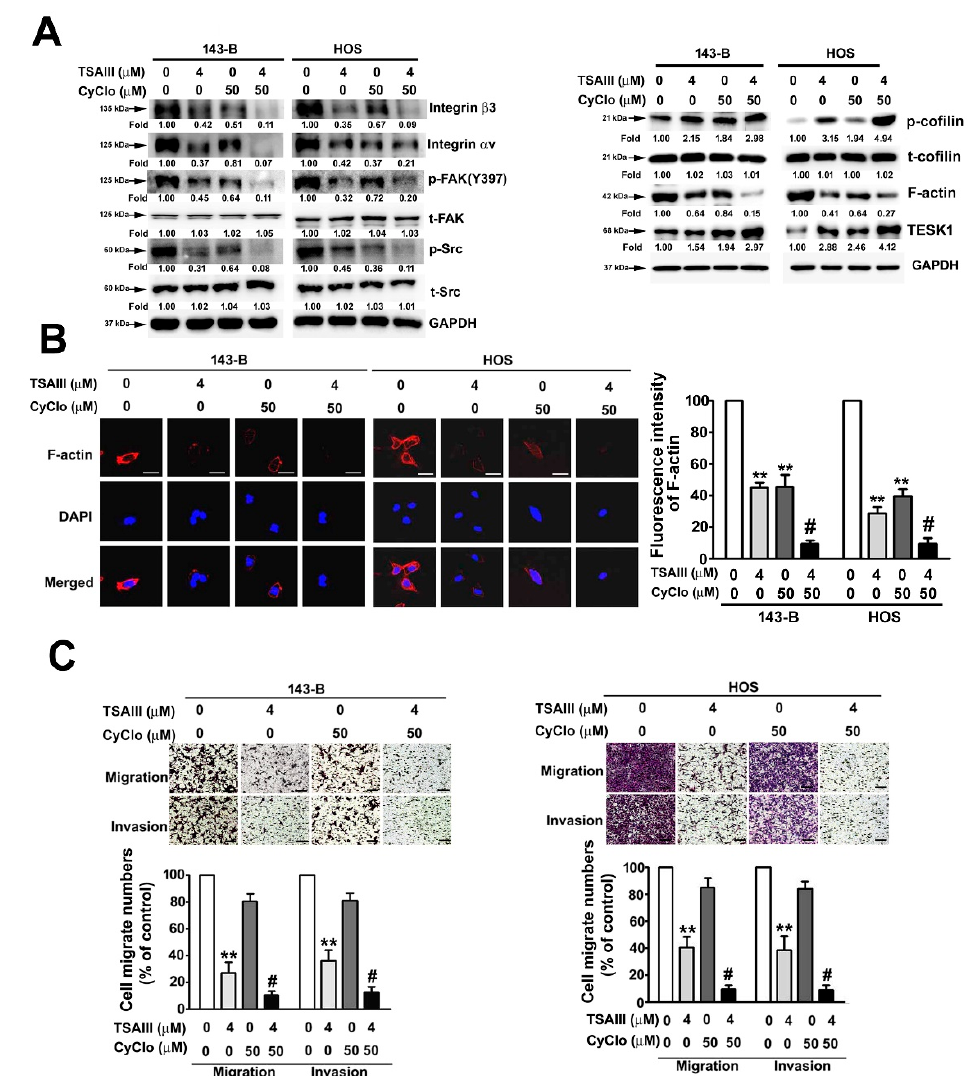
Figure 4. Synergistically inhibitory effect of TSAIII and Cyclo on migration and invasion of human osteosarcoma cells. ( A ) Human 143-B and HOS osteosarcoma cells were treated with various concentrations of TSAIII (0 and 4 µ M) and/or Cyclo (0 and 50 µ M) and then harvested to detect the expression and activation of cytoskeletal-related proteins through immunoblotting. Glyceraldehyde-3-phosphate dehydrogenase (GAPDH) was used as the internal control. ( B ) A change in the expression of cytoskeletal F-actin was observed in human 143-B and HOS osteosarcoma cells using immunofluorescence analysis. ( C ) The migration and invasion capacities of human 143-B and HOS osteosarcoma cells were measured after treatment with TSAIII in the presence or absence of Cyclo for 18 h (migration) or 24 h (invasion). ** p < 0.01 versus control; # p < 0.05 versus treatment with Cyclo alone. Cyclo denotes Cyclo(RGDyK) (Intergin inhibitor) . Scale bar: 50 µ m.